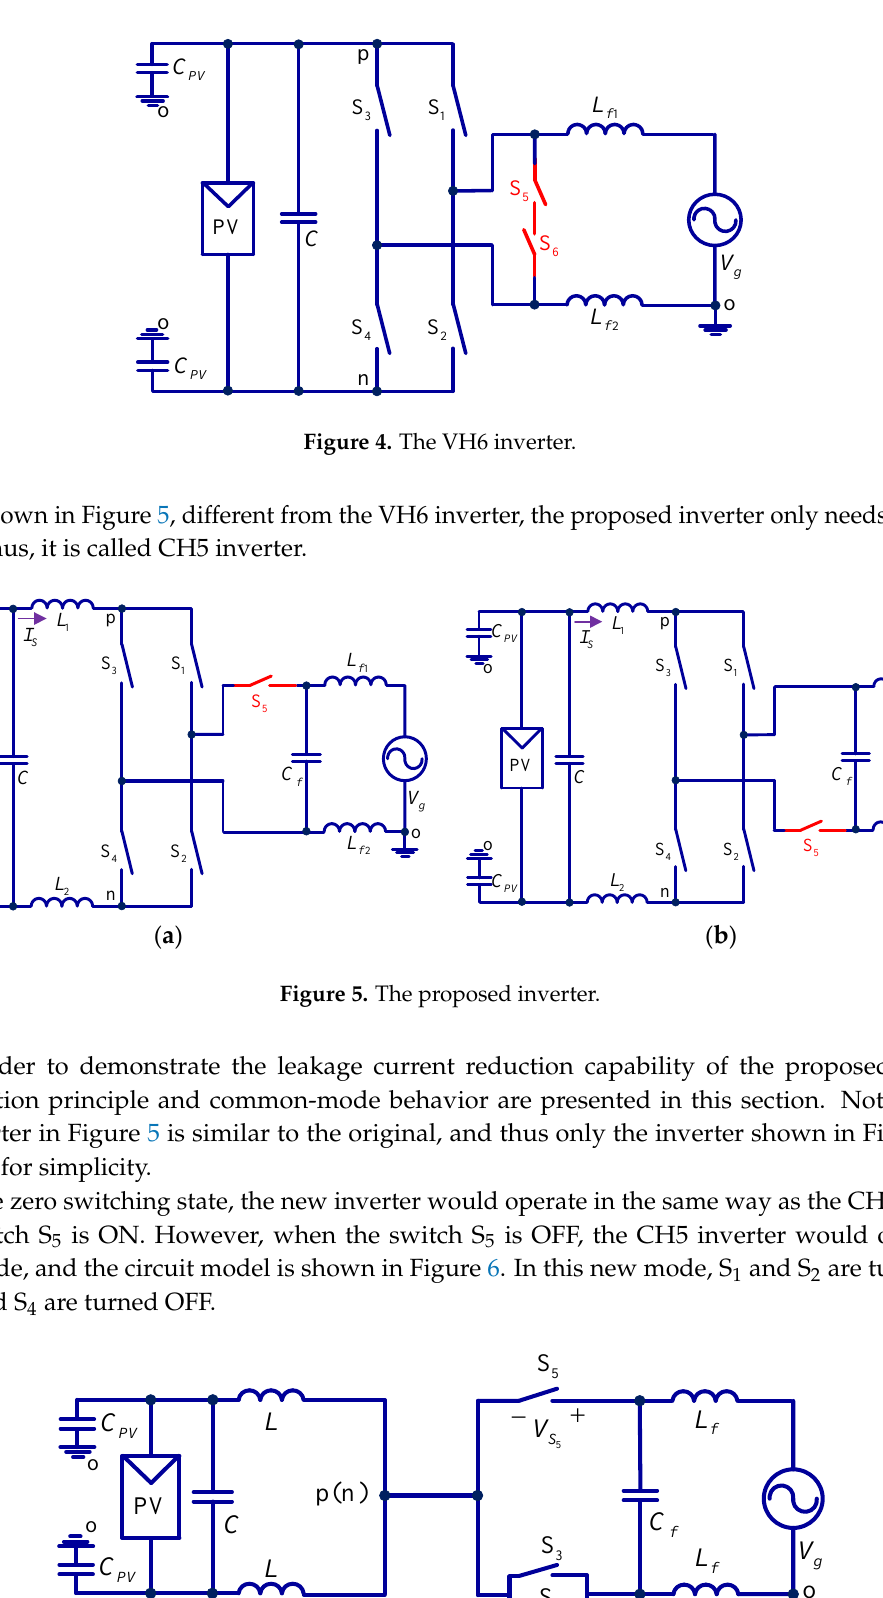
Figure 6. Circuit model of CH5 in new mode.